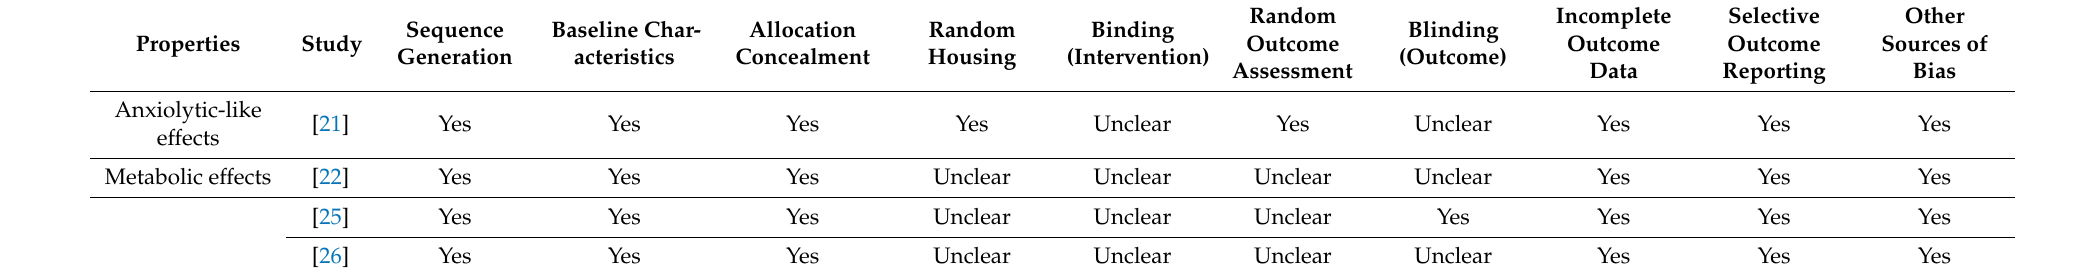
Table 2. Descriptive results of the biases found in the included animal studies following SYRCLE’S guidelines